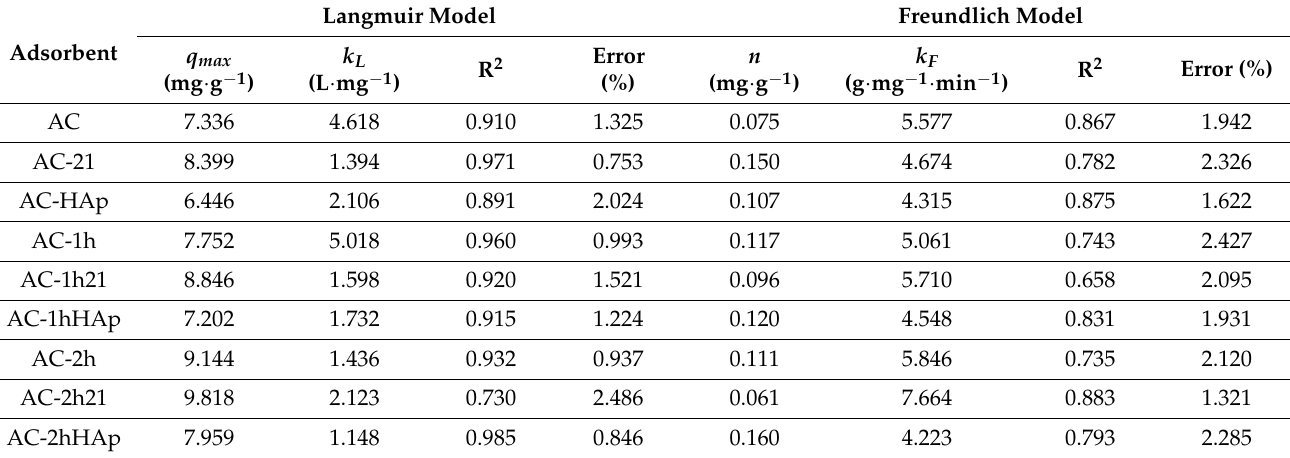
Table 2. Parameters of the adsorption